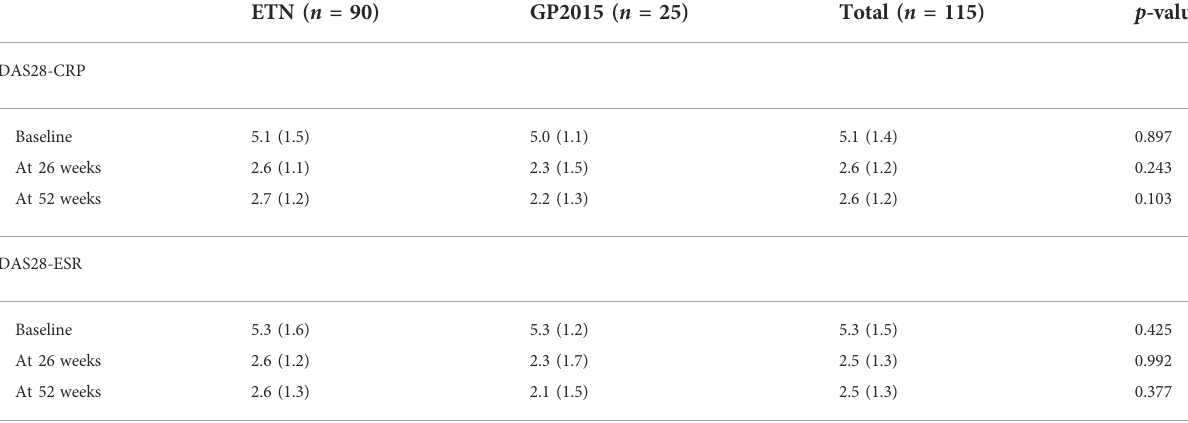
TABLE 2 Evolution of DAS28 at baseline, at 26 and 52 weeks after the initiation and comparison between ETN and GP2015 groups.